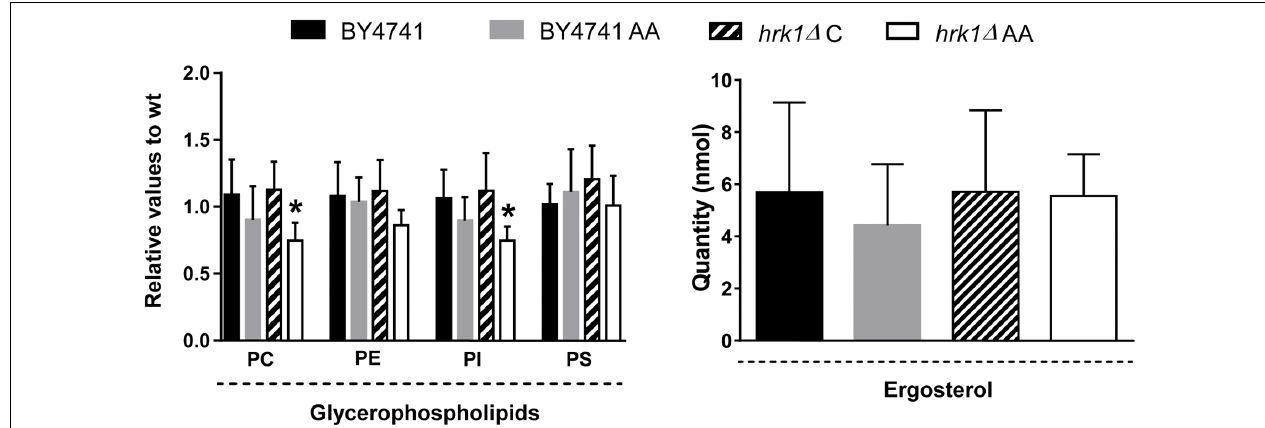
FIGURE 4 | Acetic acid leads to a decrease in glycerophospholipids (PC and PI) levels in the hrk1 (cid:49) mutant strain, but not in the BY4741 strain, but has no effect in ergosterol levels. The cells were grown in MM4 growth medium, supplemented (AA) or not with 50 mM acetic acid (at pH 4.0). Relative values were calculated as described in the section “Materials and Methods.” ∗ Significant differences, obtained by Tukey’s or Dunn’s test ( P < 0.05) compared with the respective control condition. The results were calculated from biological replicates ( n = 4 for ergosterol and n = 7 for glycerophospholipids) and are given as the mean ± standard deviation. PC, Phosphatidylcholine; PE, Phosphatidylethanolamine; PI, Phosphatidylinositol; PS, Phosphatidylserine.